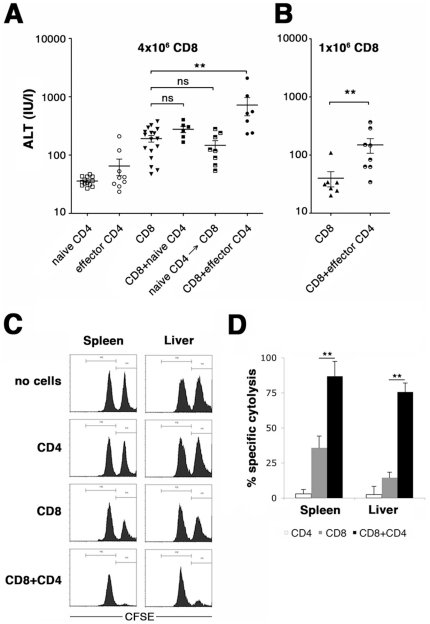
Hepatitis is amplified by effector but not naive CD4 T-cells.(A) Four million naïve (open squares) or effector (open circles) OT-II T-cells were transferred alone or together with 4 million naïve OT-I T-cells (filled squares and circles) into TF-OVA mice. Naïve OT-II T-cells were also transferred three days prior to transfer of OT-I T-cells to allow timely redistribution to the liver (half-filled squares). As a control, 4 million naïve OT-I T-cells (filled triangles) were transferred alone. Alanine aminotransferase levels were determined at day 5. Individual values and mean ± SEM are depicted (**p<0.005 by Mann-Whitney test). (B) One million naïve OT-I T-cells were transferred alone (filled triangles) or together with 4 million effector OT-II T-cells (half-filled circles) into TF-OVA mice. Alanine aminotransferase levels were determined at day 5. Individual values and mean ± SEM are depicted (**p<0.005 by Mann-Whitney test). (C) Four million effector OT-II T-cells were transferred alone (CD4) or together with 1 million naïve OT-I T-cells (CD8+CD4) into TF-OVA mice. As controls, 1 million naïve OT-I CD8 T-cells (CD8) were transferred alone or no cells were transferred (control). At day 6, equal numbers of CFSEhigh SIINFEKL-pulsed and CFSElow unpulsed B6 splenocytes were injected. After 5 hours cells from the indicated organs were analyzed for CFSE staining. Histogram blots depict data gated on CFSE-positive cells. (D) Antigen-specific cytolysis was calculated as described in methods. Cumulative results are depicted from n = 6 mice per group (mean ± SEM; ** p<0.005 by Mann-Whitney test).